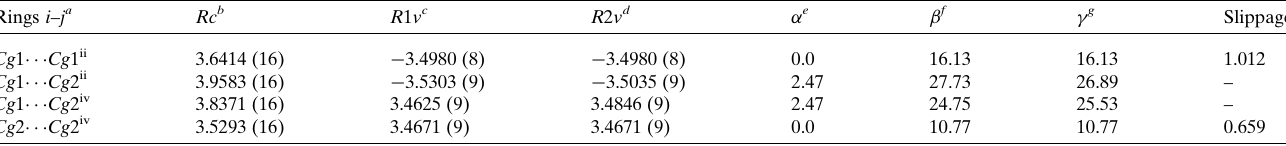
Table 3 Geometrical parameters (A˚ , (cid:3) ) for (cid:3) – (cid:3) stacking. ( a ) Cg 1 and Cg 2 are the centroids of the (N1/C1/N2/C6/C7) and (N2/C1–C5) rings, respectively; ( b ) centroid–centroid distance between ring i and ring j ; ( c ) vertical distance from ring centroid i to ring j ; ( d ) vertical distance from ring centroid j to ring i ; ( e ) dihedral angle between the first ring mean plane and the second ring mean plane of the partner molecule; ( f ) angle between the centroid of the first ring and the second ring; ( g ) angle between the centroid of the first ring and the normal to the mean plane of the second ring of the partner molecule. Rings i – j a